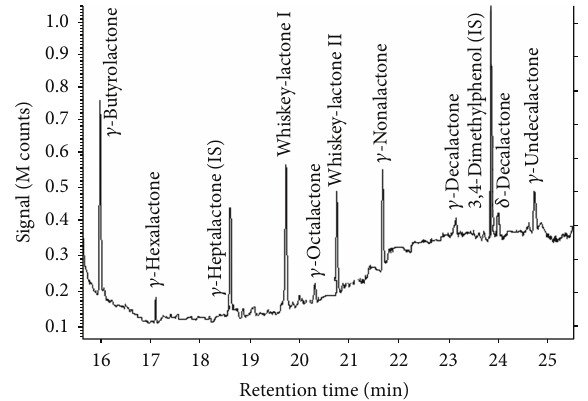
Figure1:TICchromatogramobtainedwithaPAfiberforasynthetic wine spiked with the different analytes.